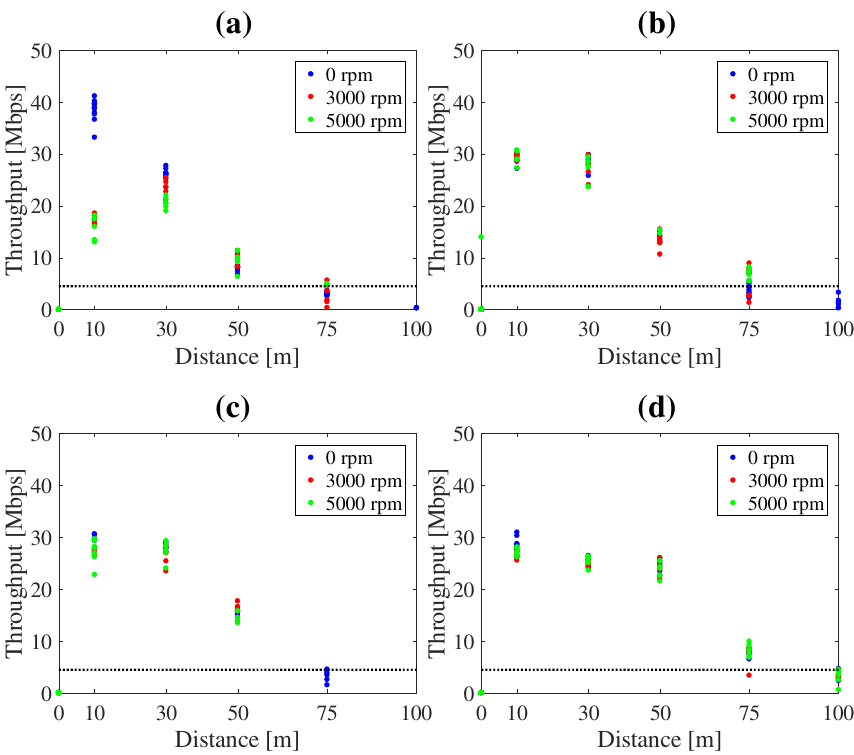
Figure 14. Throughputs by antennas type. ( a ) diversity; ( b ) Yagi (small); ( c ) collinear; ( d ) Yagi (large).